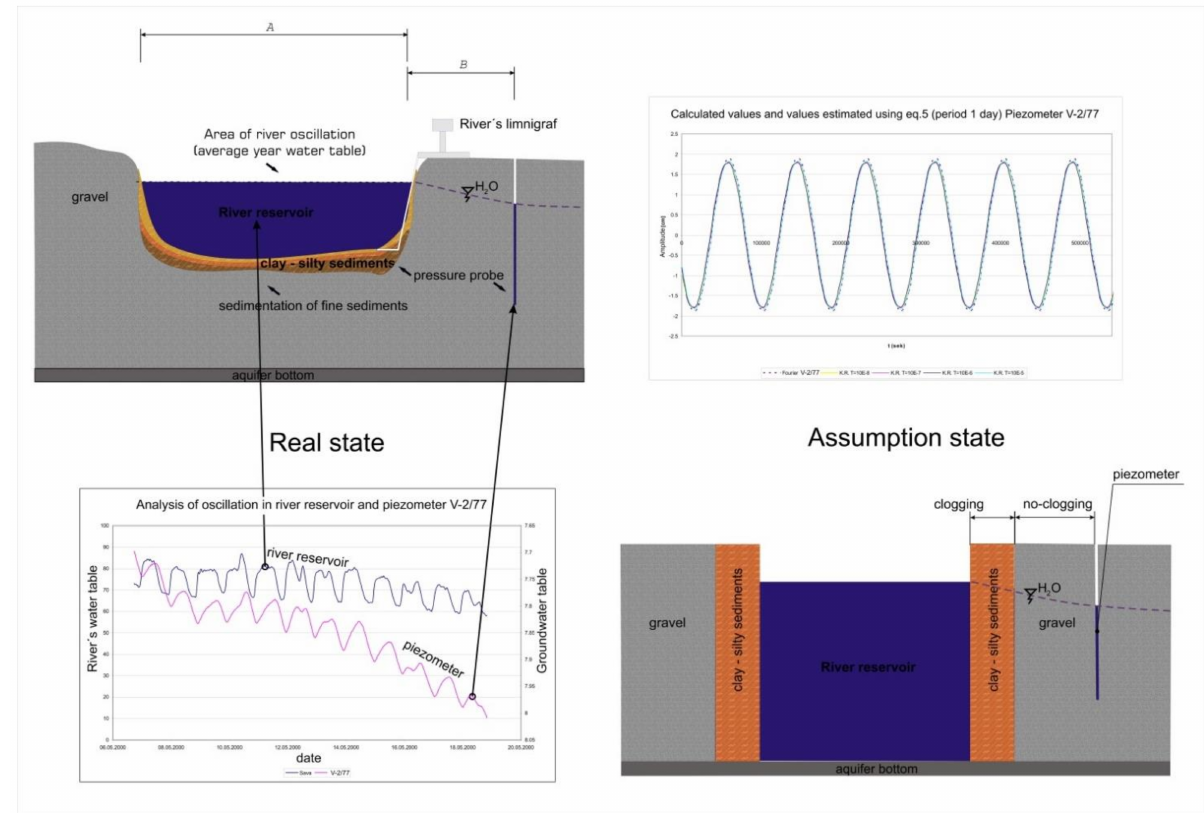
Figure 12. Simplified conceptual model of pressure disturbance transmission from river reservoir into